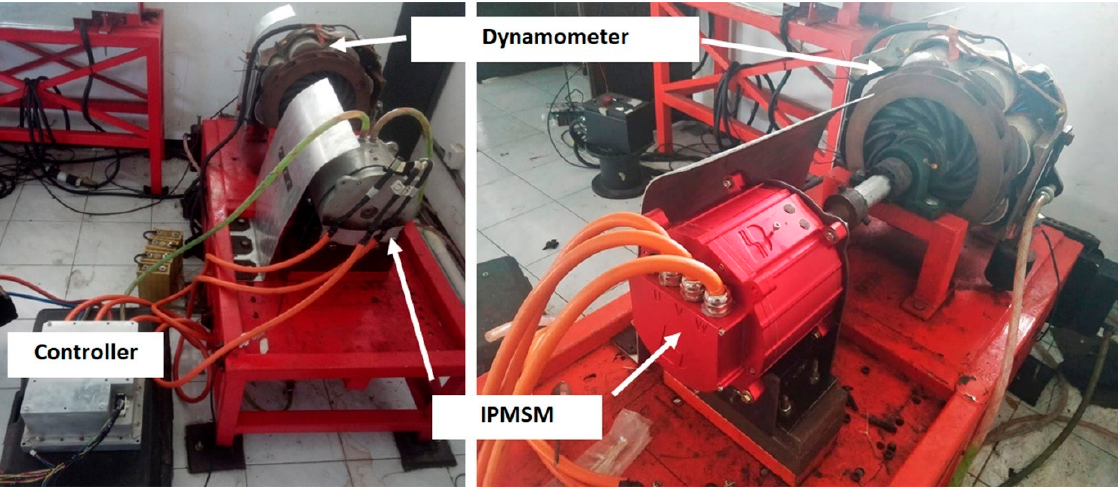
Figure 17. Snapshot of the experimental set-up of IPMSM and its controller performance measurement.